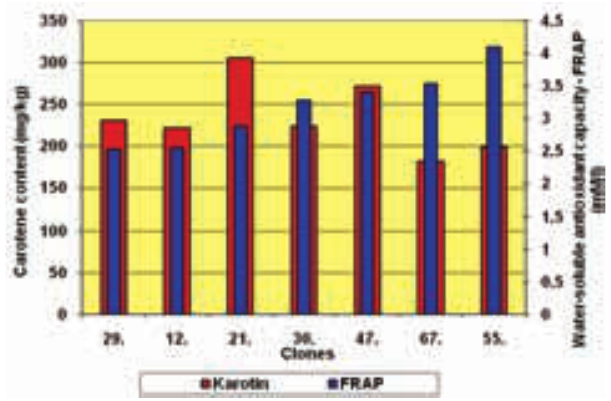
Figure 2. Carotene content and water-soluble antioxidant capacity (FRAP) of Lycium berries, in